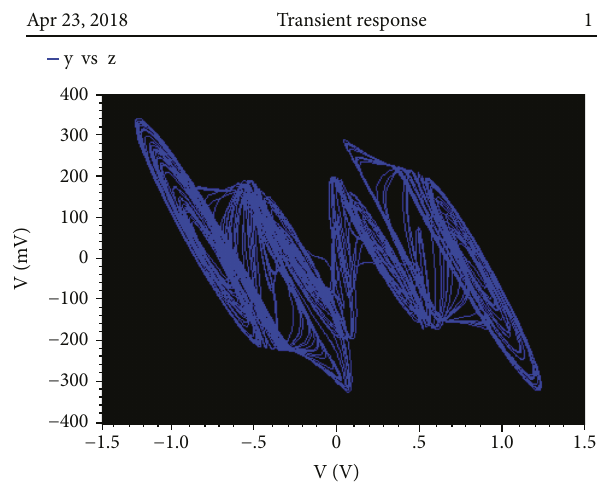
Figure 21: The phase portrait in the x - z plane (S turned on).